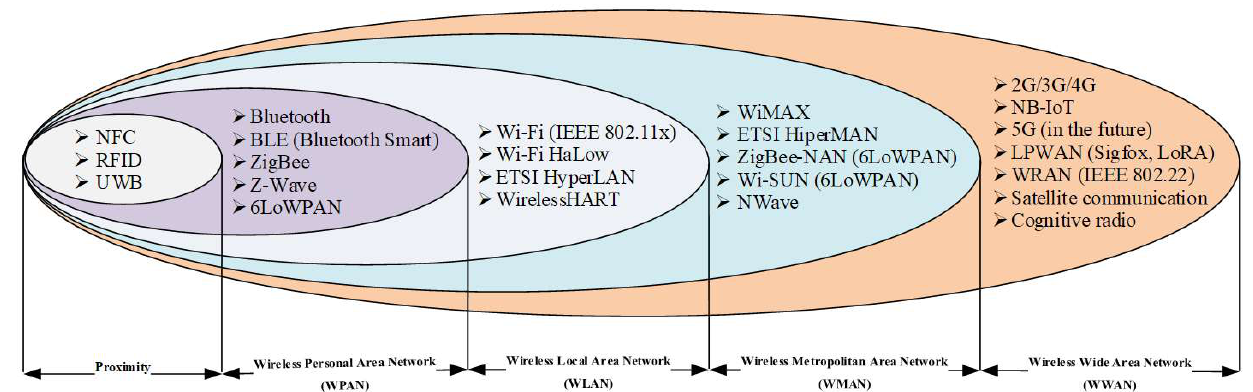
Figure 2 . Wireless communication technologies suitable for Internet of Things